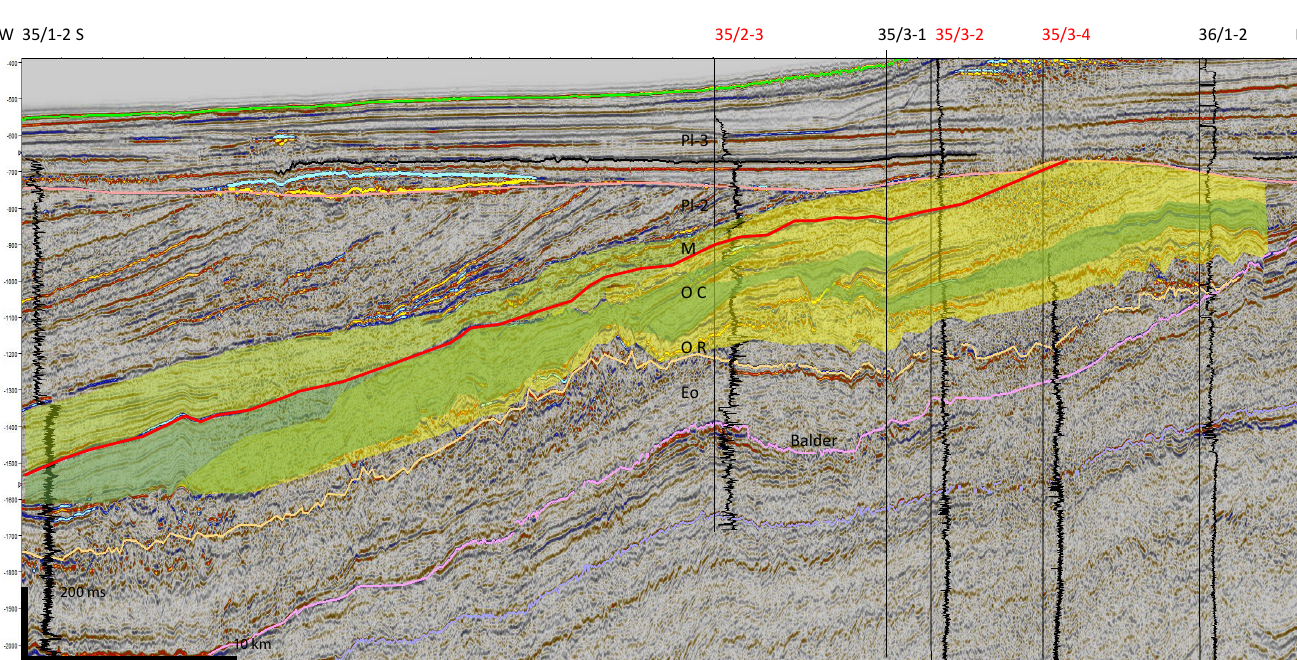
Figure 38. NW–SE profile through 5 wells offshore Nordfjord. The Oligocene, Miocene and part of the Pleistocene sections are analysed in wells 35/1–2 S, 35/3–1 and 36/1–2. The Miocene section is a northern equivalent to the Sula Formation while the sandy part of the Oligocene belongs to the Berle Formation. The lithologies are coloured in the Miocene and Chattian sections. Boundaries are gradational and the typically medium grained, clean sands in the east (yellow) grade to alternating sand and shale with more fine-grained sand to the west (yellowish green). The same pattern is found in the Eocene and the Rupelian. Pl–2: Pleistocene with clinoforms prograding from the east, Pl–3: Pleistocene above URU, Pl–1 is not present. M: Miocene, mainly upper Miocene, but middle and lower Miocene occur in 35/1–2